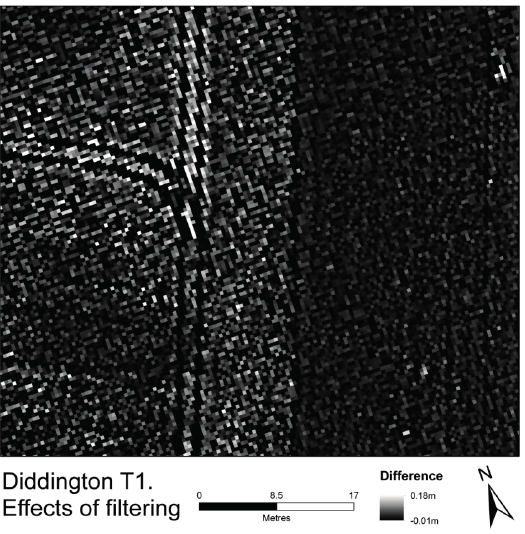
Figure 8. Result of examination of the impact of spatial filtering on the resultant DTM used to produce the multi-temporal airborne LiDAR derived CHMs at the Diddington site.